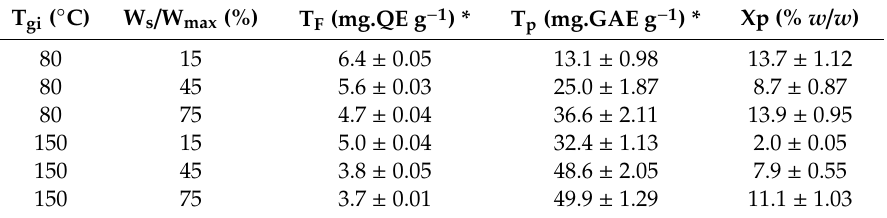
Table 2. Total flavonoids and total polyphenols contents of the spouted bed dried extracts. T gi ( ◦